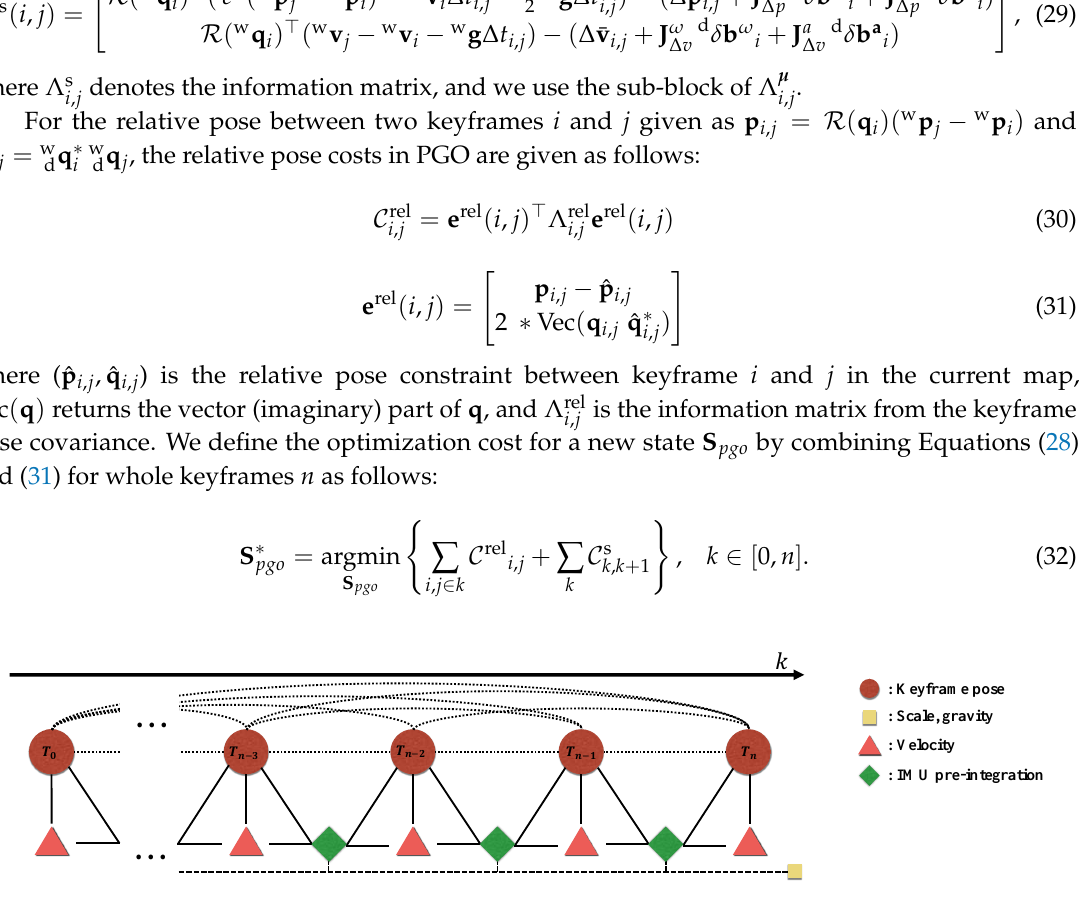
Figure 8. The proposed pose graph optimization model for bootstrapping. We estimate the global metric scale and gravity vector while maintaining the relative poses between keyframes computed only from the visual